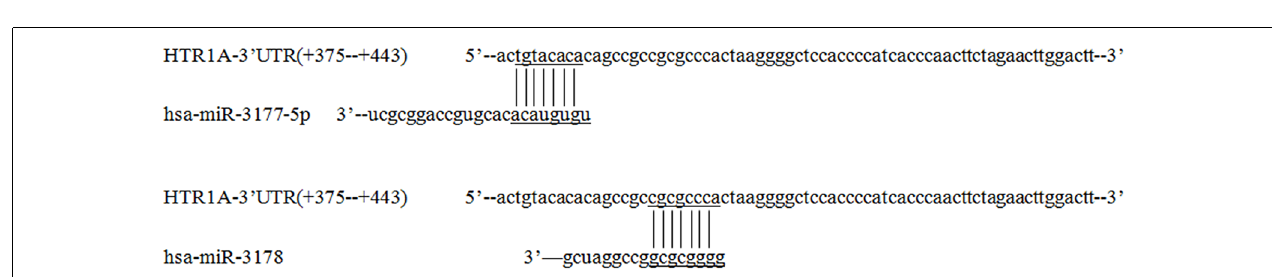
FIGURE 3 | Relative mRNA expression of the functional sequences of the HTR1A gene 3 (cid:48) -UTR region (A–D) . Relative mRNA expression of 3 (cid:48) -UTR functional sequences in the HTR1A gene was not significantly different in the four cell lines. Real-time PCR was calculated by the 2 − ∆∆ CT method, and the LSD-T test was used to compare the two samples.